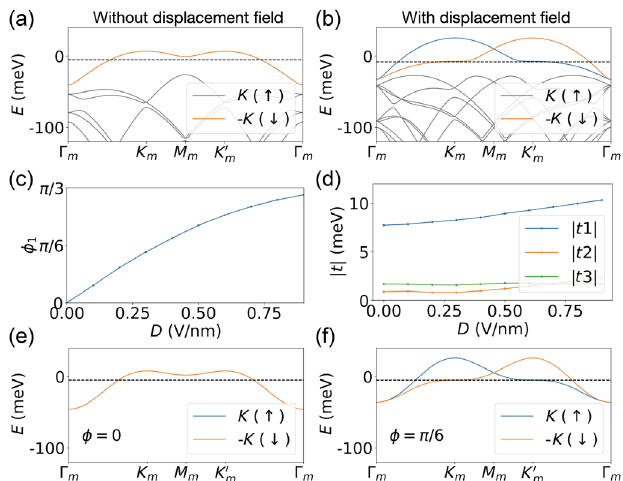
FIG. 10. (a),(b) Sketch of the band structure of tWSe 2 with and without a displacement field using the continuum model (Refs. [8,10]). The blue (orange) line highlights the topmost valence ⃗ K ⃗ K band from the ( − ) valley with spin up (down) dominant. The dotted line indicates the Fermi level at half filling. (c),(d) Tight- binding parameters as a function of displacement field D . The phase of nearest-neighbor hopping ϕ 1 and the hopping amplitude of nearest, second, and third neighbors j t 1 j , j t 2 j , and j t 3 j , respectively, are extracted from previous DFT and tight-binding calculation at θ ¼ 5 . 09 ° [4]. (e),(f) Band structure of the moir´e Hubbard model [Eq. (1)] at ϕ ¼ 0 and π = 6 , where only the nearest-neighbor hopping t 1 is considered.